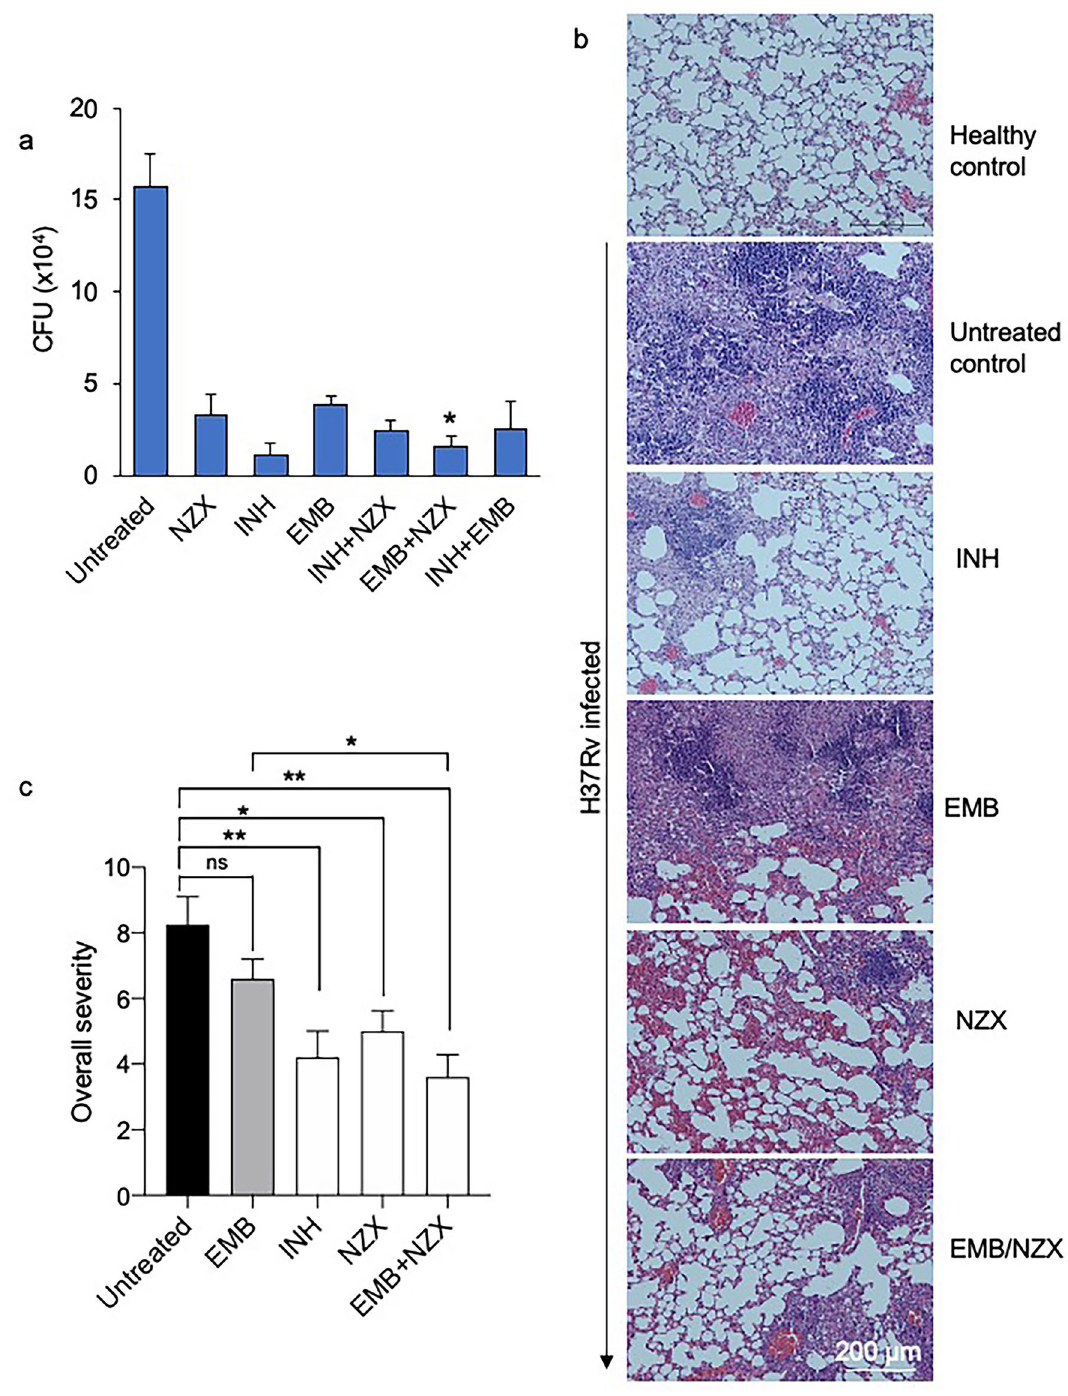
Figure 2. Murine evaluation of drug combinations. ( a ) Treatment induced bacterial reduction compared to the untreated control (isoniazid p = 0.0159, ethambutol p = 0.0159, NZX p = 0.0159). Combination treatment with ethambutol/NZX reduced bacterial load significantly more than ethambutol treatment alone (p = 0.0317), but not from NZX treatment alone (p = 0.4206). We found no significant difference between the other groups. Results presented as mean ± sd. All p values were calculated by unpaired Student’s t -test, Mann–Whitney or ANOVA (*p < 0.05). ( b ) Representative eosin (H&E) staining showing lung sections from M. tuberculosis H37Rv infected mice and uninfected control mice. H&E staining of untreated lungs showed tissue destruction and granuloma formation. Mice treated for four weeks with INH, NZX or NZX/EMB showed decreased tissue destruction. Scale bar 200 μm. ( c ) Results of the blinded lung inflammatory score. Data are presented as the mean ± SEM ( n = 4–5). p values were determined using a one-way ANOVA with Tukey’s post hoc test. * p ≤ 0.05; ** p ≤